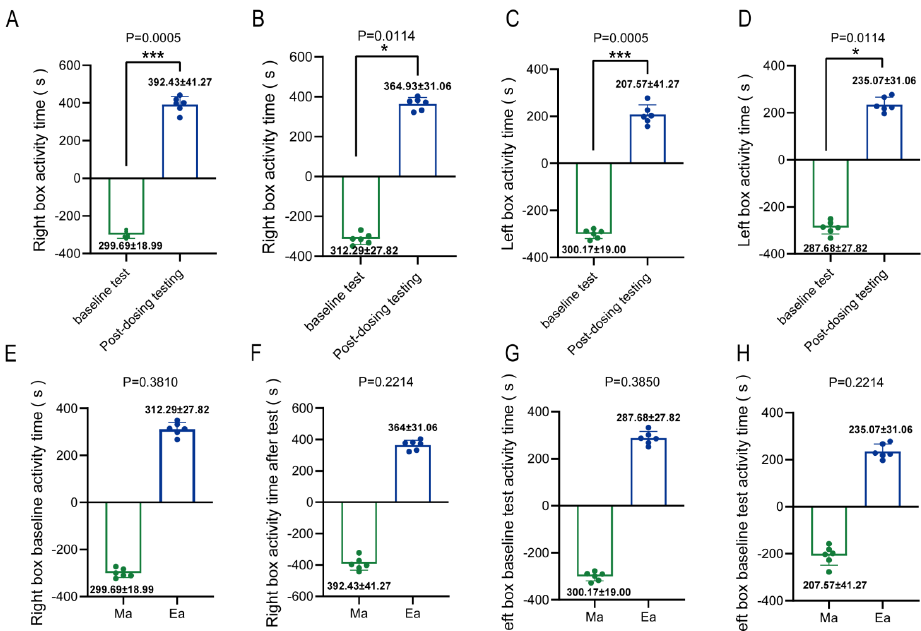
Figure 1. Addictive behavior of Methamphetamine-administered mice, setting the right box as the companion box. ( A ) Right box activity time of mice in group Ma; ( B ) Right box activity time of mice in group Ea; ( C ) Left box activity time of mice in group Ma; ( D ) Left box activity time of mice in group Ea; ( E ) Right box baseline activity time of mice in group Ma versus Ea; ( F ) Right box test activity time of mice in group Ma versus Ea; ( G ) Left box baseline activity time of mice in group Ma versus Ea; ( H ) Left box test activity time of mice in group Ma versus Ea. * Indicates post-dosing versus baseline level, p < 0.05; *** indicates post-dosing versus baseline level, p < 0.001